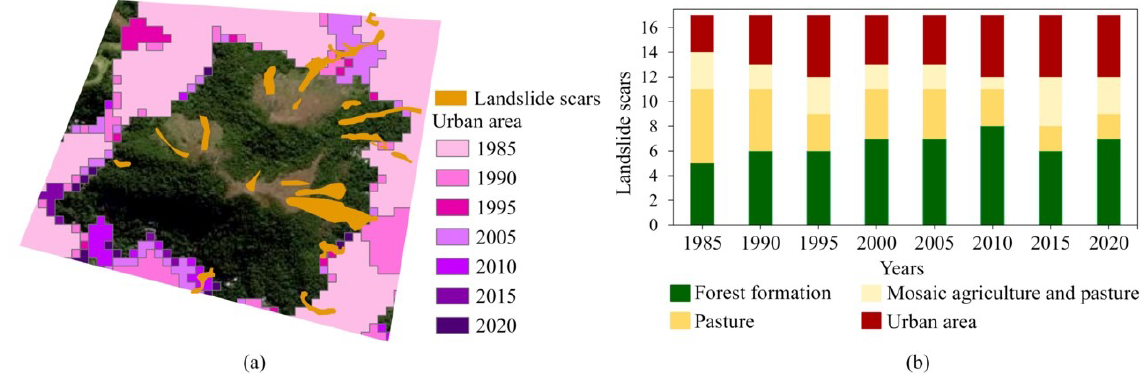
Figure 12. (a) Landslide scars superimposed in the urban area classes (the background image is from Planet) and (b) zonal statistics based on LULC classes (for every 5 years, from 1985 to 2020).